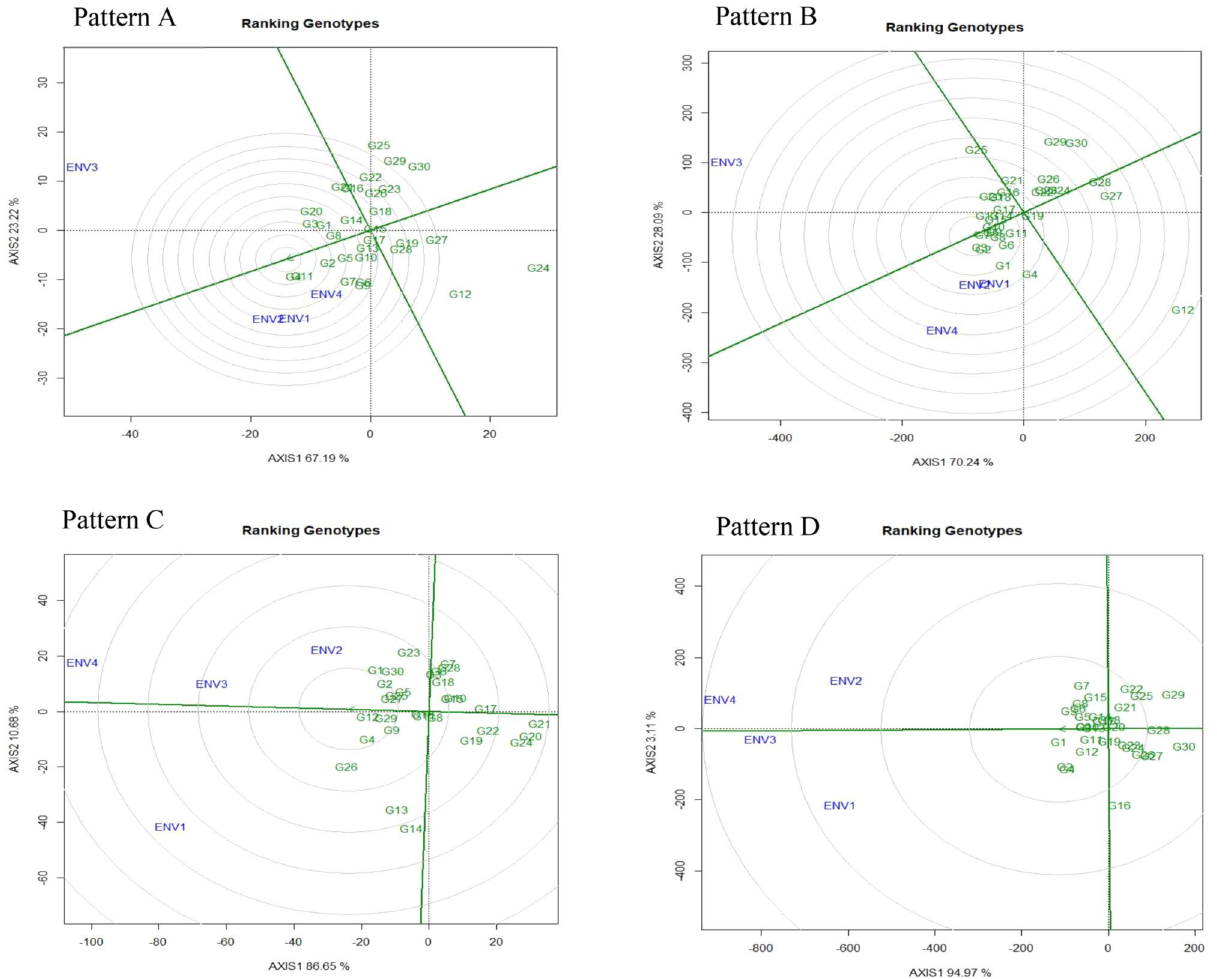
Figure 3. The GGE biplot ‘genotypes ranking’ pattern for genotype comparison with ideal genotype showing G + G × E interaction effect of 30 V . subterranea genotypes under two season two location for total number of pods (Pattern A), fresh pod weight (Pattern B), hundred seed weight (Pattern C), yield per hectare (Pattern D). The biplots were created based on Centering = 0, SVP = 2, Scaling = 0. The ideal genotype is signified by a circle within innermost concentric circles on average environment coordinate (AEC) abscissa which passed through biplot